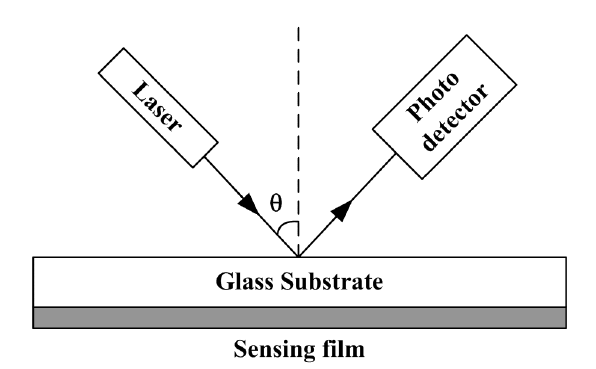
Figure 9. Kretschmann-type configuration of surface-plasmon resonance sensor